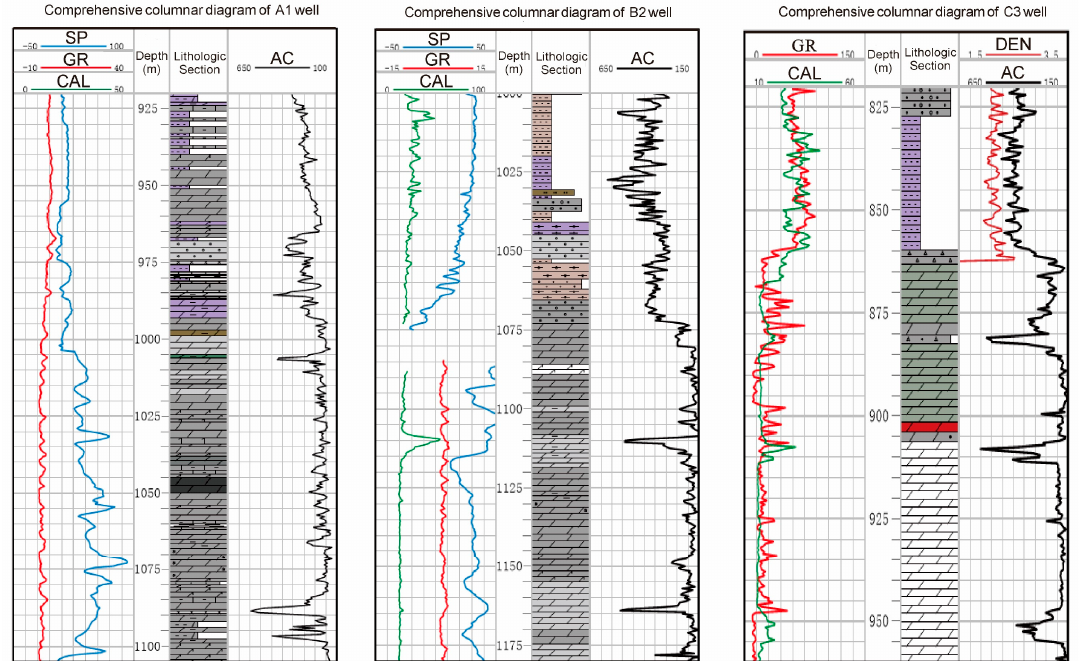
Figure 14. Comprehensive columnar diagram of typical wells in the Xiong’an New Area. ( a ) Comprehensive columnar diagram of A1 well; ( b ) Comprehensive columnar diagram of B2 well; ( c ) Comprehensive columnar diagram of C3